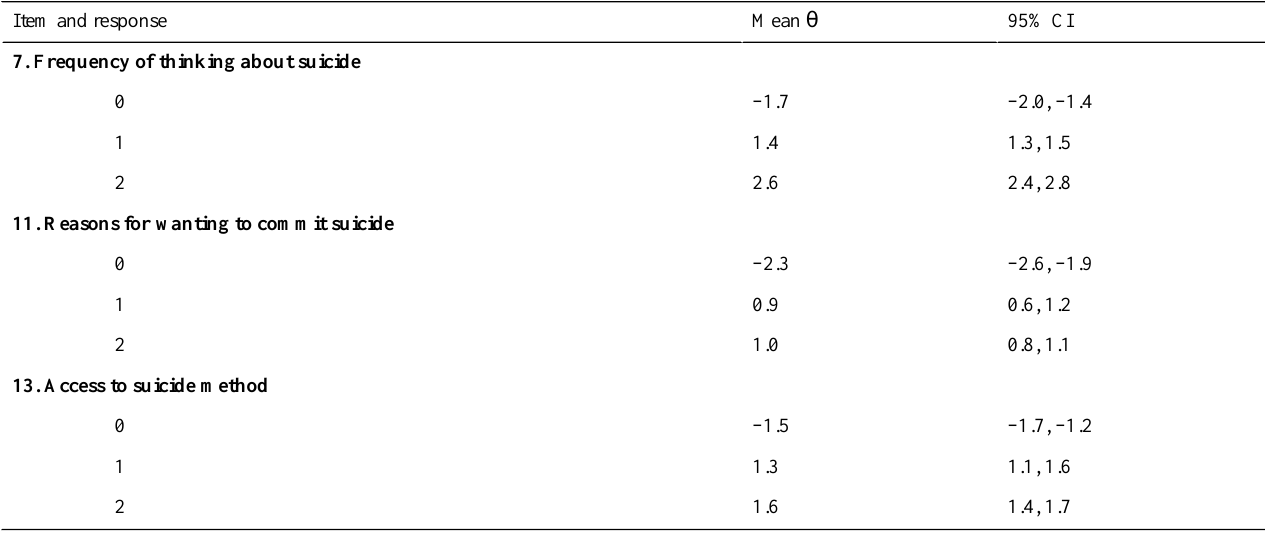
Table 3. The mean theta of patients that endorsed response option 0, 1, and 3 for items 7, 11, and 13.